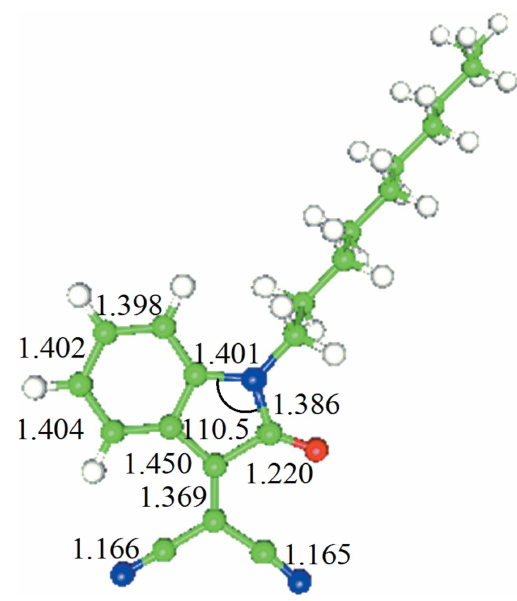
Figure 5 The B3LYP-optimized geometry of the title compound (A˚ , (cid:3) ).